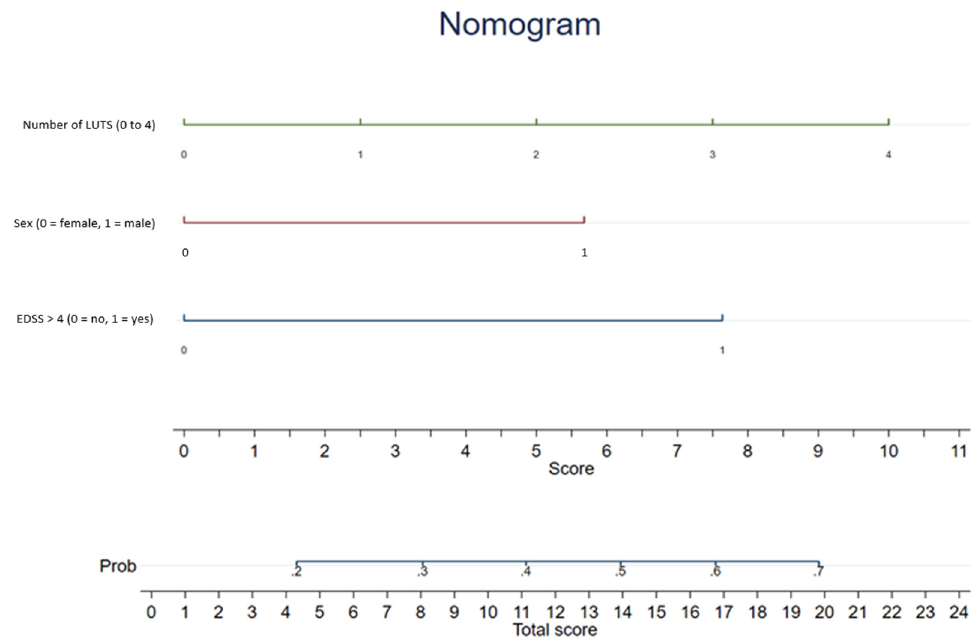
Figure 1. Nomogram combining an EDSS ≥ 5, male gender, and the number of LUTS to predict the probability of at least one urodynamic risk factor for UUT damage.